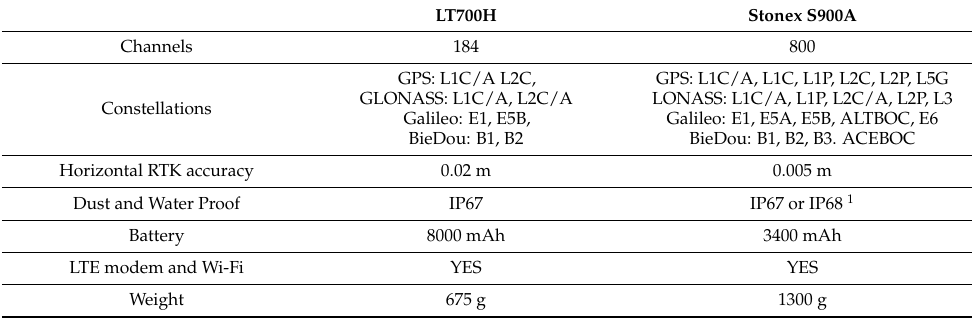
Table 1. GNSS receiver